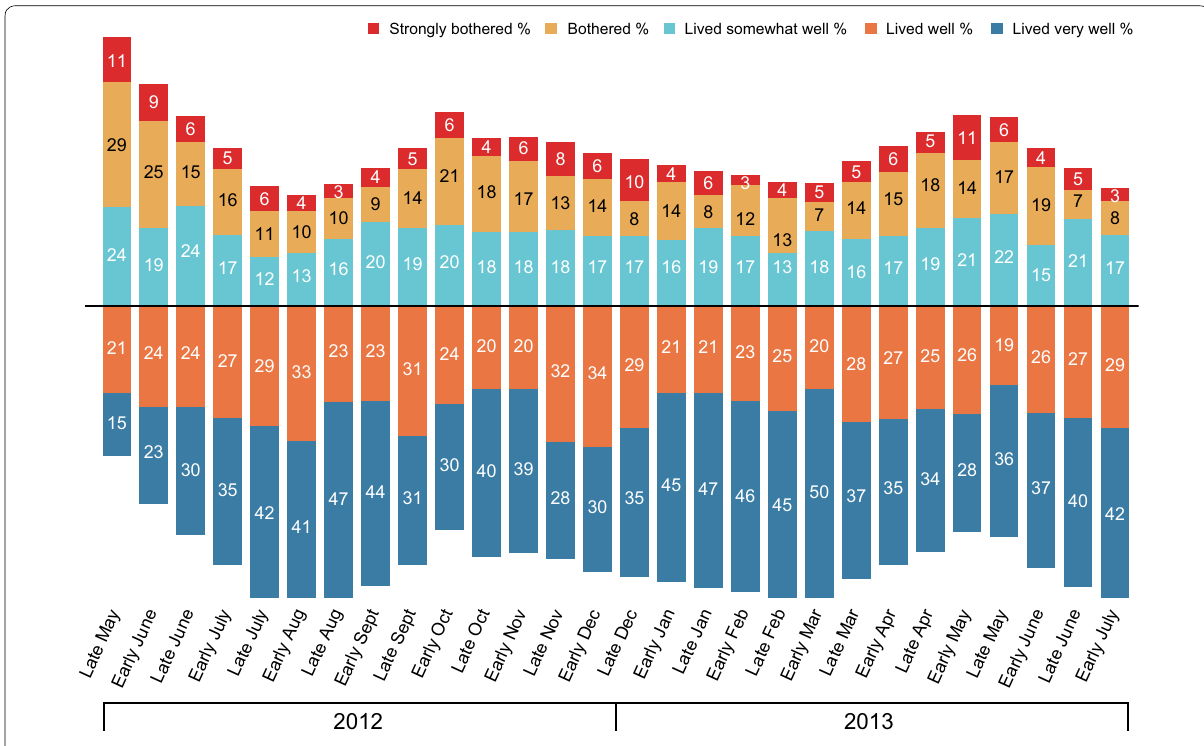
Fig. 4 Fortnightly telephone interviews of study participants: overall feeling about the bothersomeness of HDM allergy